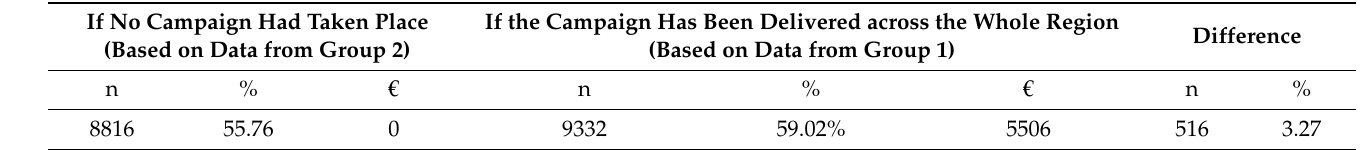
Table 5. Comparison in uptake and cost if the campaign had been delivered across the whole region versus not at